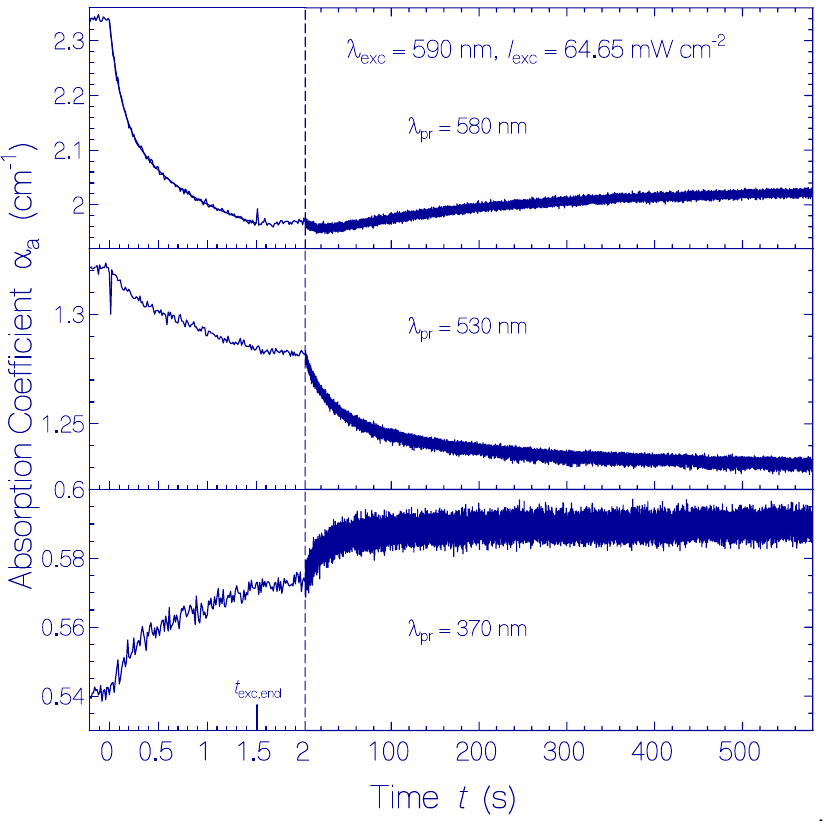
Figure 4. Temporal absorption coefficient development of QuasAr1 in pH 8 Tris buffer at the probe wavelengths λ pr = 580 nm (top part, peak absorption of Ret_580), 530 nm (middle part, near peak absorption of Ret_540), and 370 nm (bottom part, peak absorption of Ret_370) before, during, and